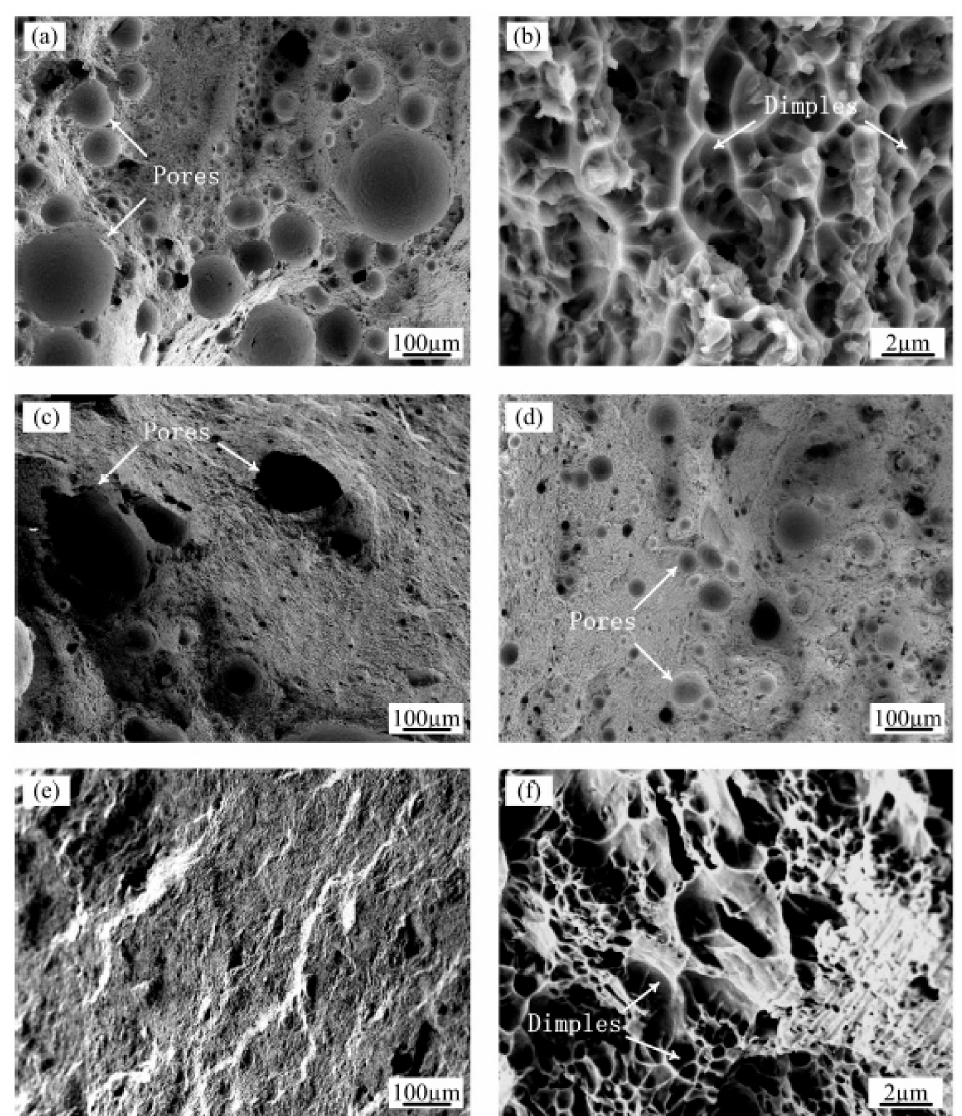
Figure 9. SEM images of the tensile fracture surfaces of ( a ) The AS sample at low magnification and ( b ) high magnification; ( c ) The AS sample with ultrasonic action at low magnification; ( d ) The RM sample at low magnification; ( e ) The RM sample with ultrasonic action at low magnification and ( f ) high